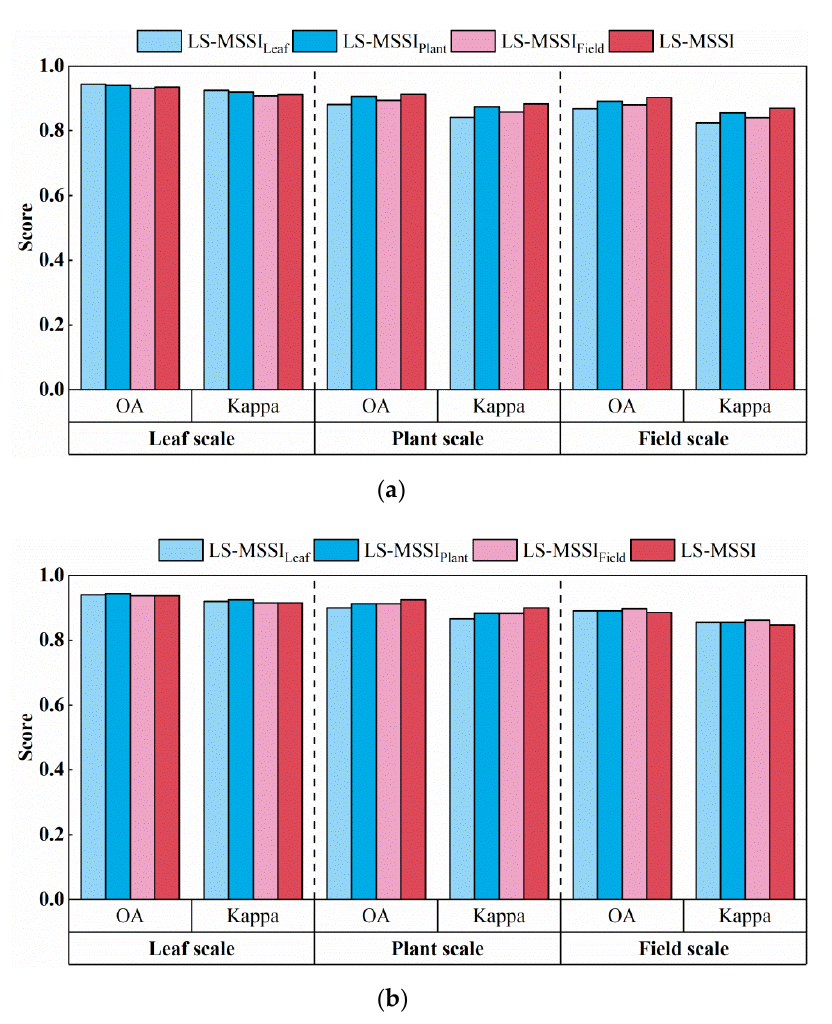
Figure 10. Comparison results of individual-scale SIs and multi-scale SI: ( a ) KNN; ( b ) MLR. From the classification results of KNN shown in Figure 10a, it can be seen that LS-MSSI Leaf obtained high accuracy at the leaf scale, while lower accuracy was obtained at the plant and the field scales. From the classification results of MLR shown in Figure 10b, it can be seen that LS-MSSI Field obtained higher accuracy at the field scale and lower accuracy at the leaf and plant scales. The above results illustrate that the SIs established at individual scales can have a high detection accuracy at their respective scale, while applications at other scales are less effective. The above conclusions are similar to the results of previous studies. For example, the authors of [20] used different SIs for disease detection at the leaf and field scales. The authors of [21] used different SIs for the detection of powdery mildew disease at the leaf and field scales, respectively. Therefore, the SIs determined at individual scales may decrease the accuracy of disease detection in span-scale applications.